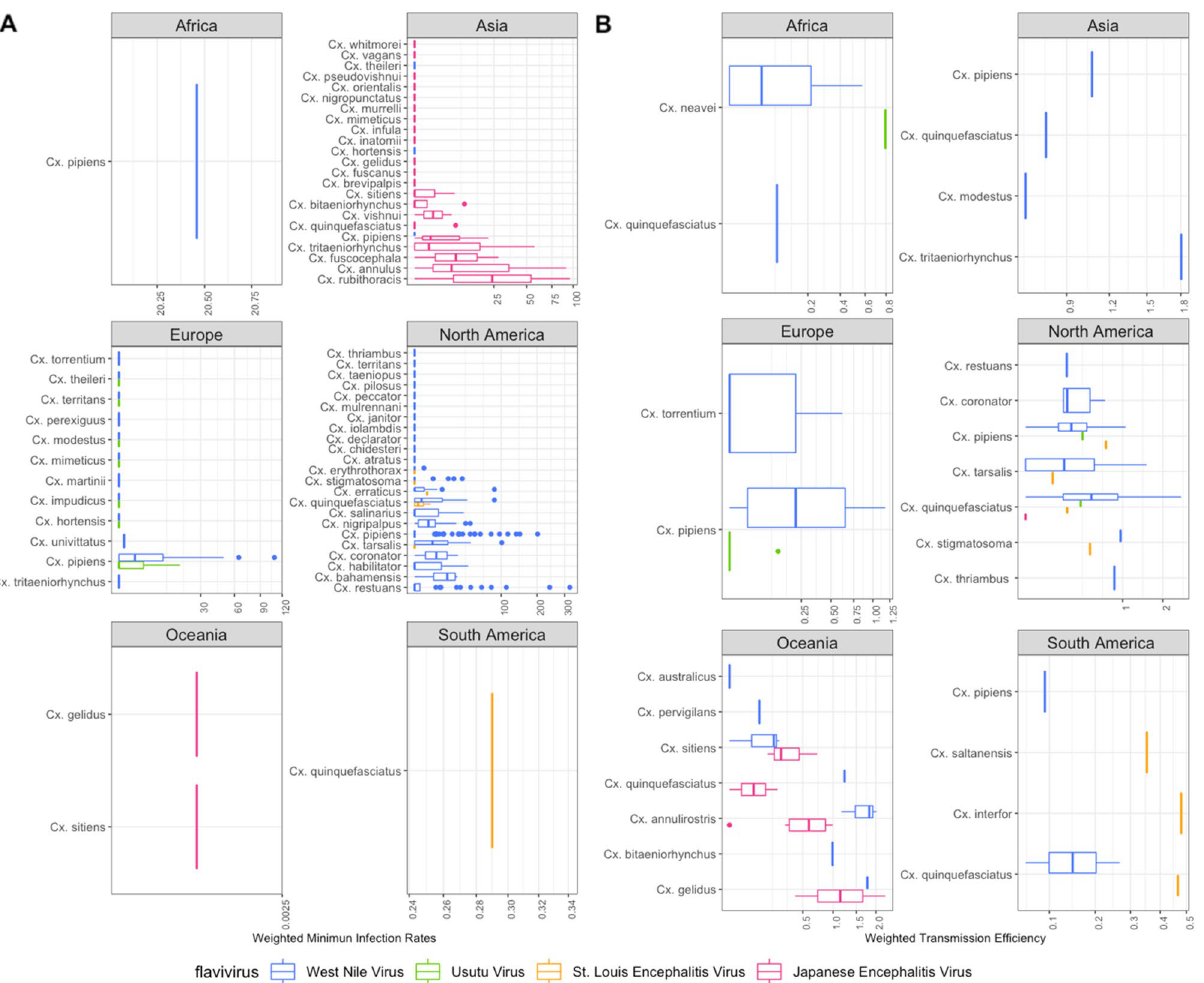
Figure 2. ( A ) Box plots for the Weighted Minimum Infection Rates and ( B ) Weighted Transmission Efficiency Rates for JES. Boxes indicate 2nd and 3rd quartiles, vertical lines upper and lower quartiles, and horizontal lines the median. Points indicate outliers. The Y axis was transformed to Sqrt (Square